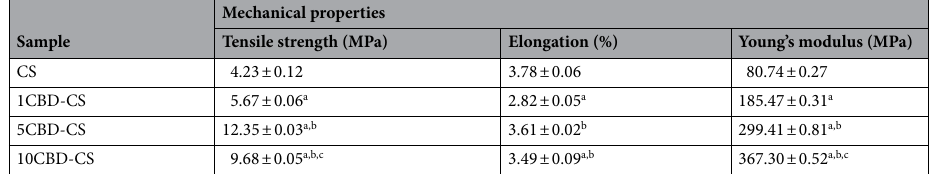
Table 1. Mechanical properties of the obtained materials. CBD-CS—cannabidiol-chitosan-based films, where 1, 5, 10CBD-CS corresponds to the weight ratio of 1, 5 or 10% of cannabidiol oil (CBD) to chitosan (CS). a,b,c Indicate p < 0.05 when compared to the corresponding CS, 1CBD-CS and 5CBD-CS, respectively.